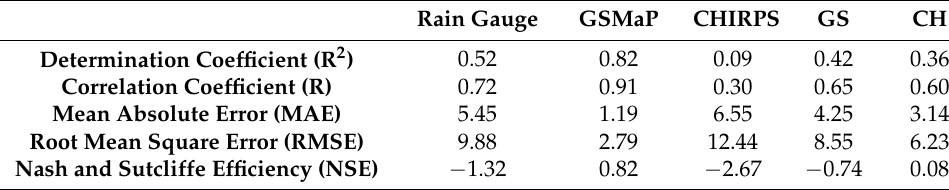
Table 3. Statistical indicators of simulated river discharge at Puente Caj ó n